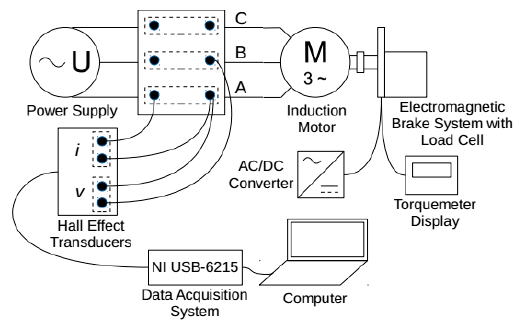
Figure 3. Schematic diagram of the laboratory setup for experimental tests. The Hall Effect transducers are represented only for one phase for purpose of simplifying the diagram, but in practice, there are three sets of transducers.